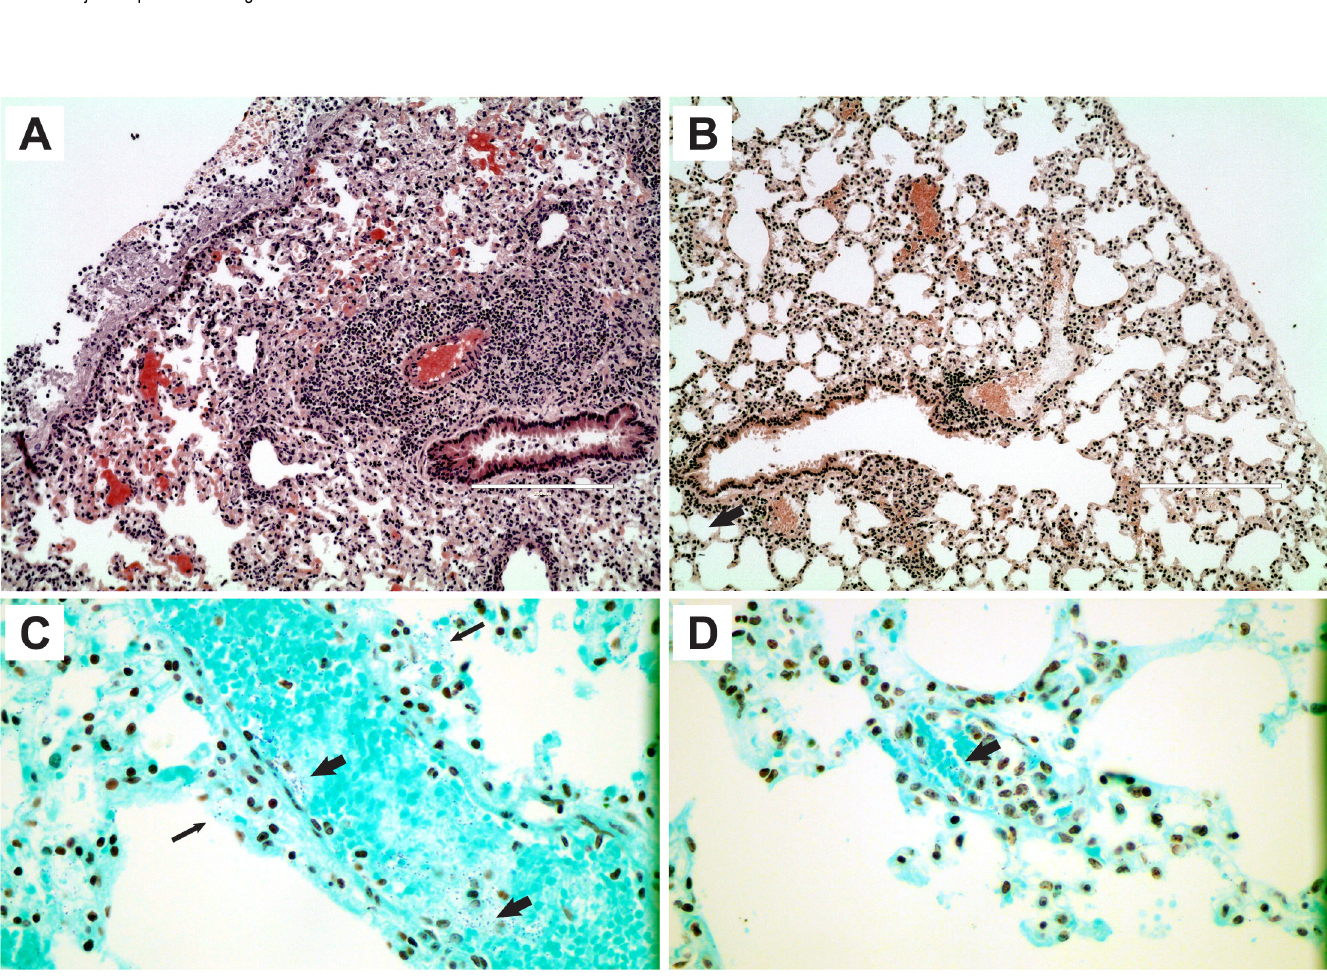
Fig 2. Differential mortality kinetics of control and SCD mice after infection. 2 – 3 month old mice were infected intranasally with 5X10 4 CFU of A66.1 S . pneumoniae and mortality (A) and weight loss (B) were measured. No statistical differences were observed for either parameter. White boxes = SCD, black boxes = controls.